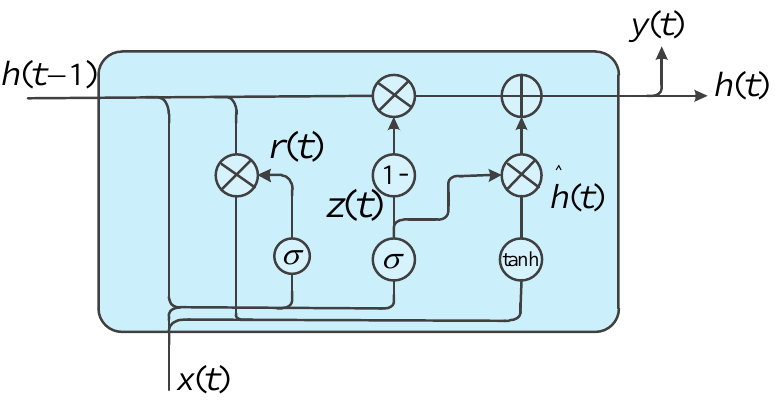
Figure 4. The structure of gated recurrent unit (GRU) network.